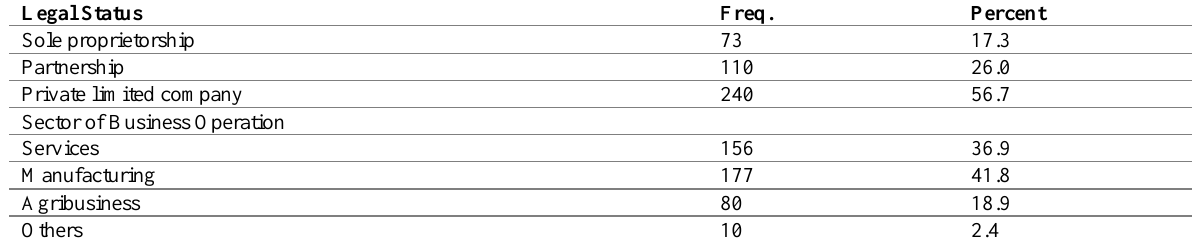
Table 3: Distribution of the study Sample by nature and sector of business